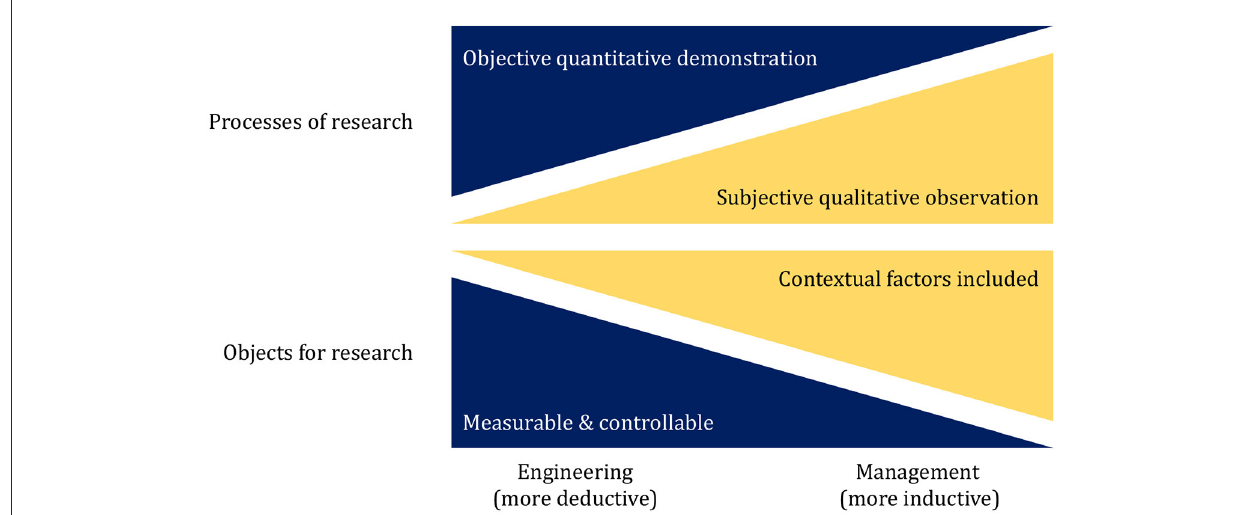
FIGURE1 Spectrum between engineering and management research (the authors’ own). A frequent object for research in engineering is a physical artifact, for example, a vehicle, whereas that in management is an organization, for instance, a manufacturing enterprise. It is important to avoid setting a clear border between the two ends because modern challenges increasingly require adopting approaches from both ends. Management research, has particularly strong roots in practice (Agarwal and Hoetker, 2007), though it is rich in theories (Suddaby, 2014). It is often interdisciplinary (Whitley, 1988; van Baalen and Karsten, 2012), involving a human (i.e., a practitioner) and being performed by a human (i.e., a researcher). It employs both inductive and deductive approaches. Here, the contexts of the organization are important, and thus it is unfeasible or impossible to experiment in an isolated environment such as a laboratory. This characteristic implies that a research process in management involves qualitative observation allowing researchers to be subjective in describing findings; the research is categorized as constructivism. Nonetheless, it is recommended to use a rigorously defined guideline. For instance, theory building from cases (Eisenhardt and Graebner, 2007) suggests adopting four elements: what, how, why, and who/where. These features of the inductive approach contrast with traditional engineering research, which expects